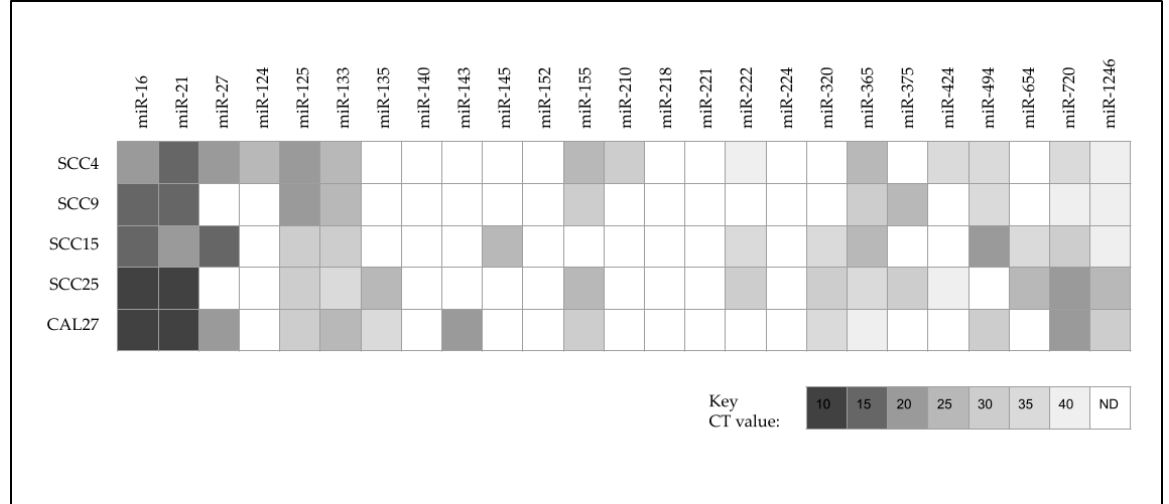
Figure 2. qPCR screening for miRNA expression among oral cancer cell lines. Screening of cDNA revealed expression of miR-16, miR-21, miR-125, miR-133, miR-365, miR-720 and miR-1246